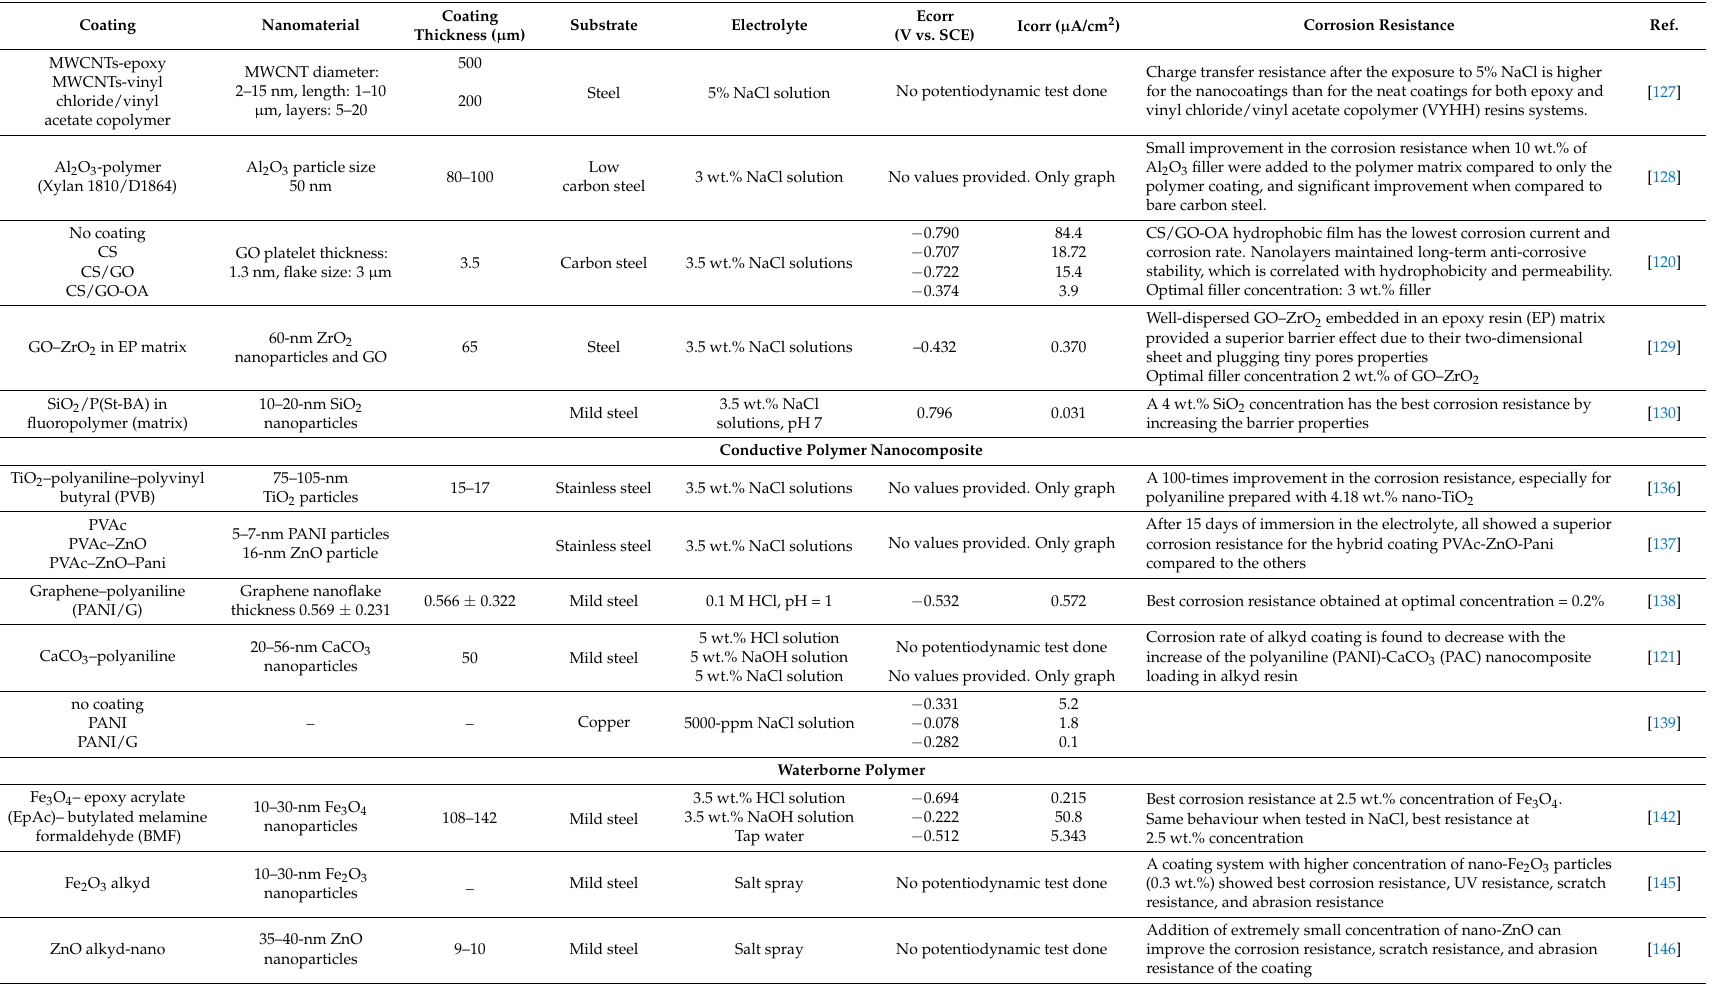
Table 3. Summary of some corrosion parameters of polymer nanocomposite